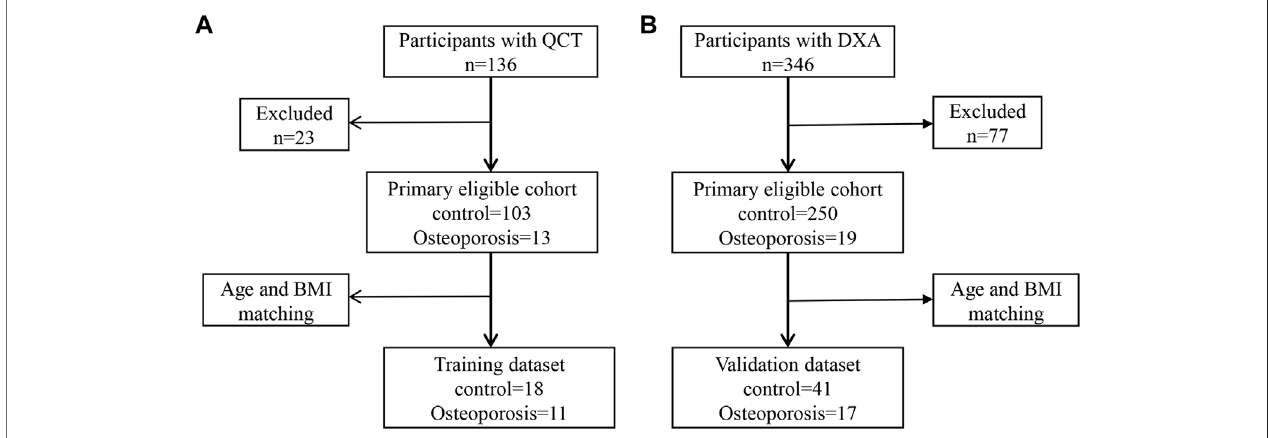
FIGURE 1 | Metagenomic genome-wide association analysis of the primary cohort. (A) Analysis of the primary cohort of osteoporosis measured by quantitative computed tomography (QCT). (B) Analysis of the primary cohort of osteoporosis measured by dual-energy x-ray absorptiometry (DXA).